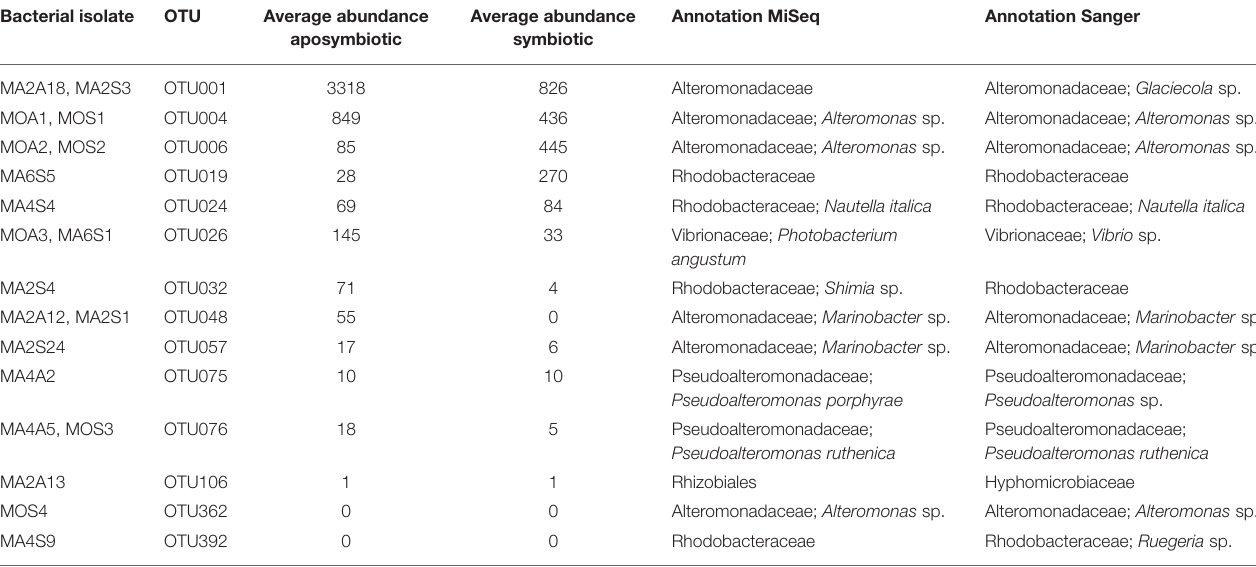
TABLE 3 | Overview of cultured isolates of Aiptasia -associated bacteria. Bacterial